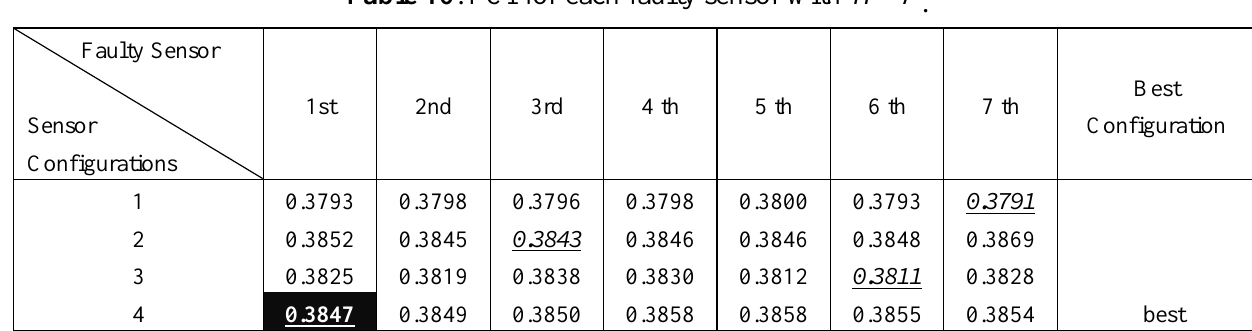
Table 10 . PCI for each faulty sensor